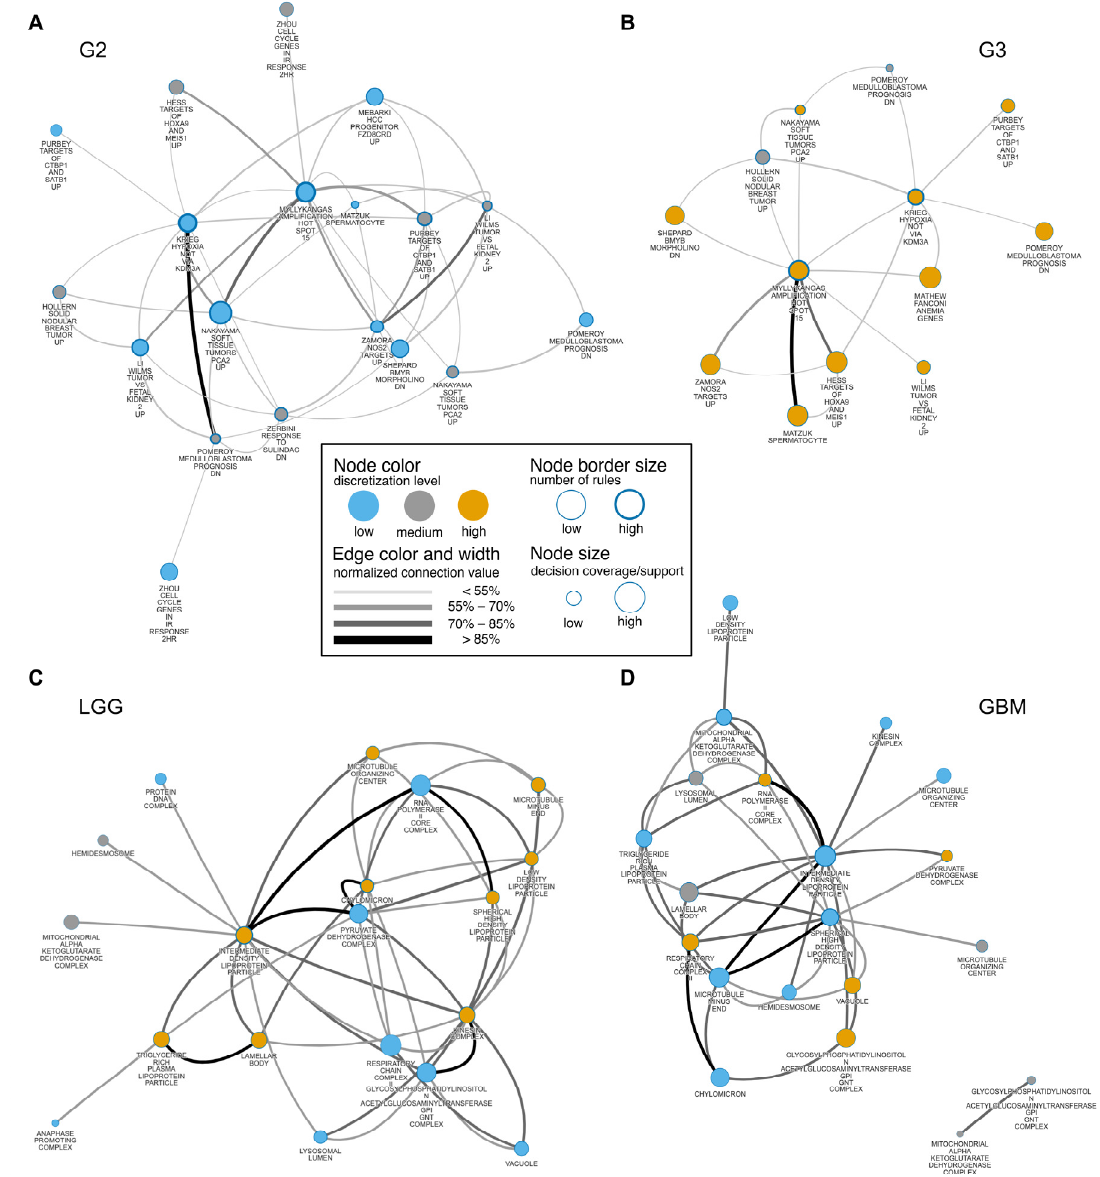
Figure 4. Rule-based network displaying the most relevant co-enrichments of annotations obtained from ( A , B ) the CGP collection for the GII vs. GIII model (Table S7) and from ( C , D ) the GOCC collection for the LGG vs. GBM model (Table S8). The networks show the 20 most connected nodes obtained from the top 10% of significant rules (FDR-adjusted p -value < 0.01) based on the rule connection. Connection values of nodes and edges represent a strength of co-enrichment from the classifier. Subnetworks were generated separately with respect to the decision class for each